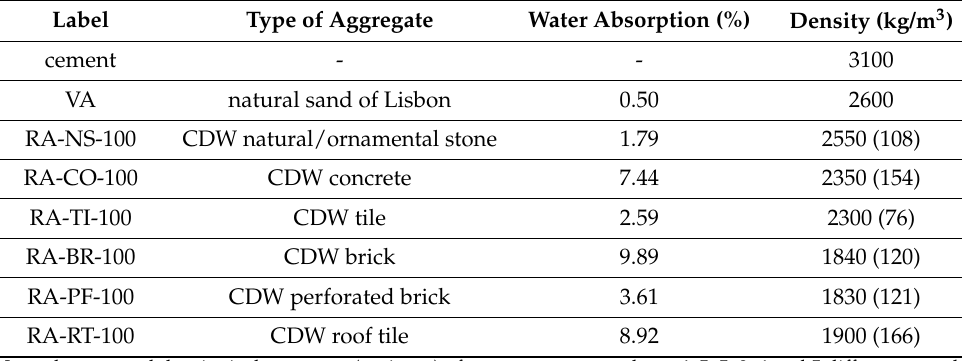
Table 2. Physical properties of cement, VA and RA.